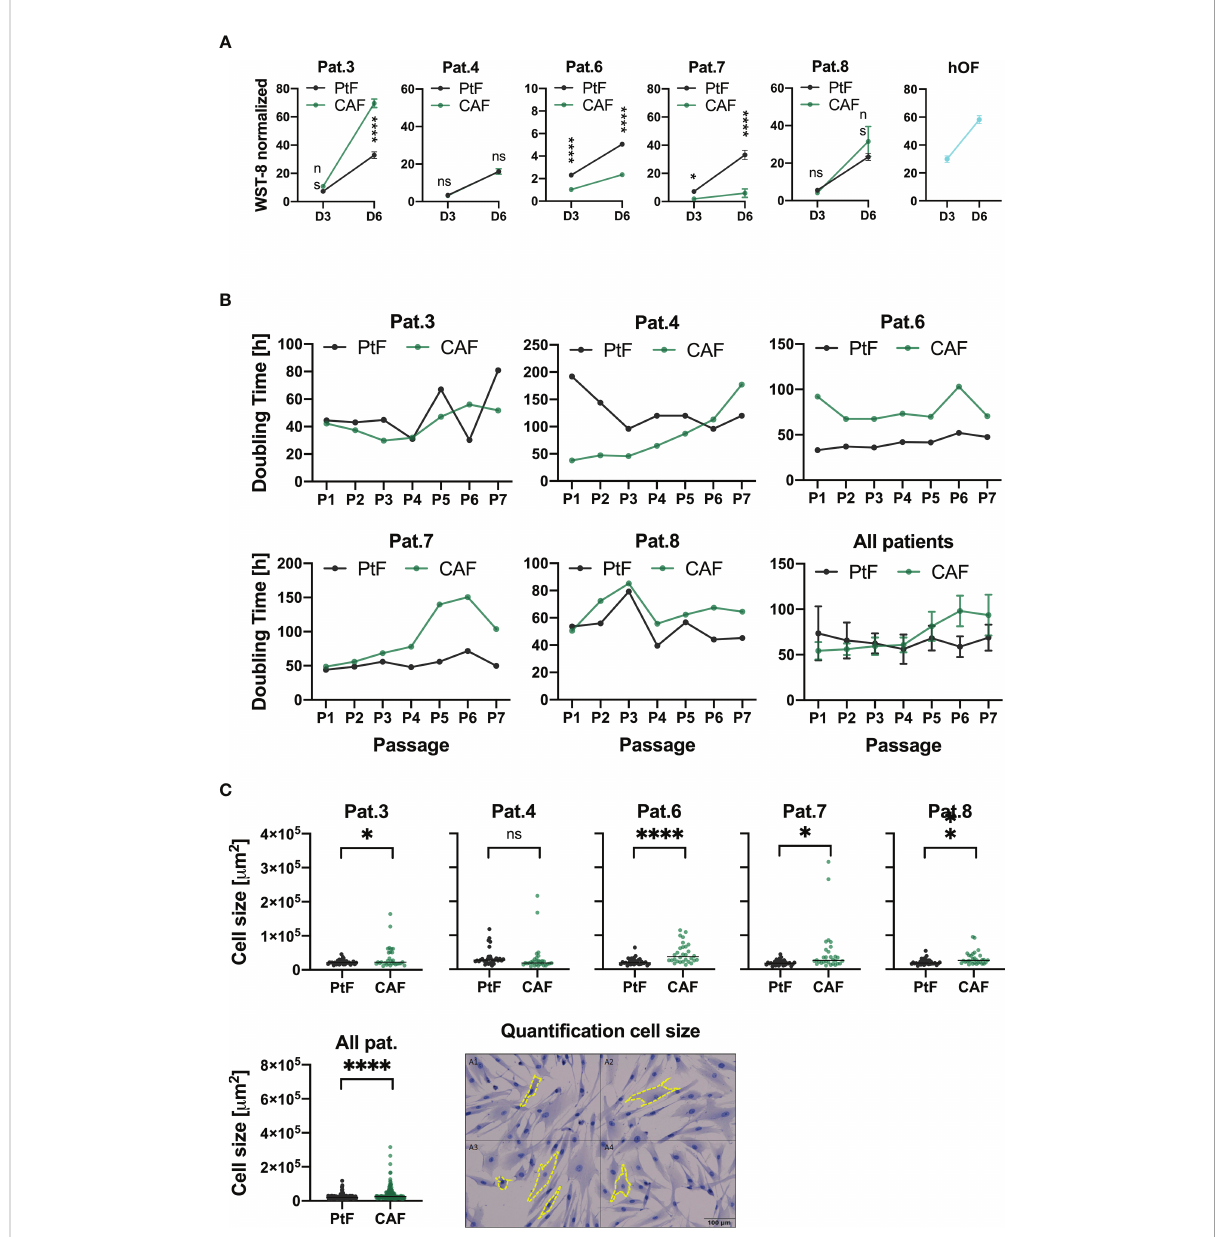
FIGURE 3 Proliferation, doubling times and cell size of PtFs and CAFs. (A) Cell proliferation of PtFs and CAFs of individual patients (Pat.3, Pat.4, Pat.6, Pat.7 and Pat.8), and human oral fi broblasts (hOF) were measured at D3 and D6 after seeding using a WST-8 assay. Normalized mean ± SD absorption values from n=3 independent experiments are shown. (B) Doubling time at each passage of matched CAFs and PtFs of all individual patients was calculated from passages 1-7. Averaged doubling times of CAFs and PtFs of all patients combined is shown in the bottom right. (C) Cell sizes of PtFs and CAFs were quanti fi ed using a software-based approach. Quanti fi ed cell sizes im mm 2 (n=30 per sample) are shown. Representative image showing cell size determination (yellow dotted line) on an E-cadherin-stained sample is shown. P-values: ns > 0.05; * ≤ 0.05; ** ≤ 0.01; **** ≤